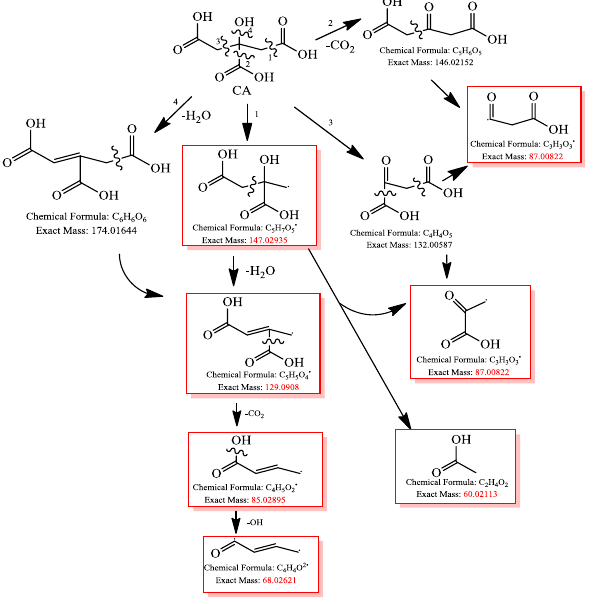
Scheme 1. Possible fragmentation pathways for citric acid.